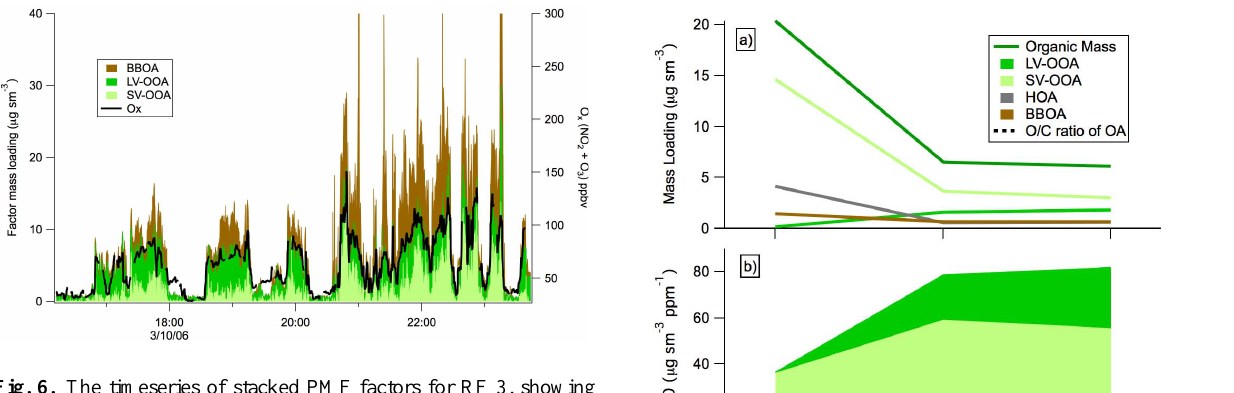
Fig. 6. The timeseries of stacked PMF factors for RF 3, showing the correlation between the sum of SV-OOA and LV-OOA and O x .